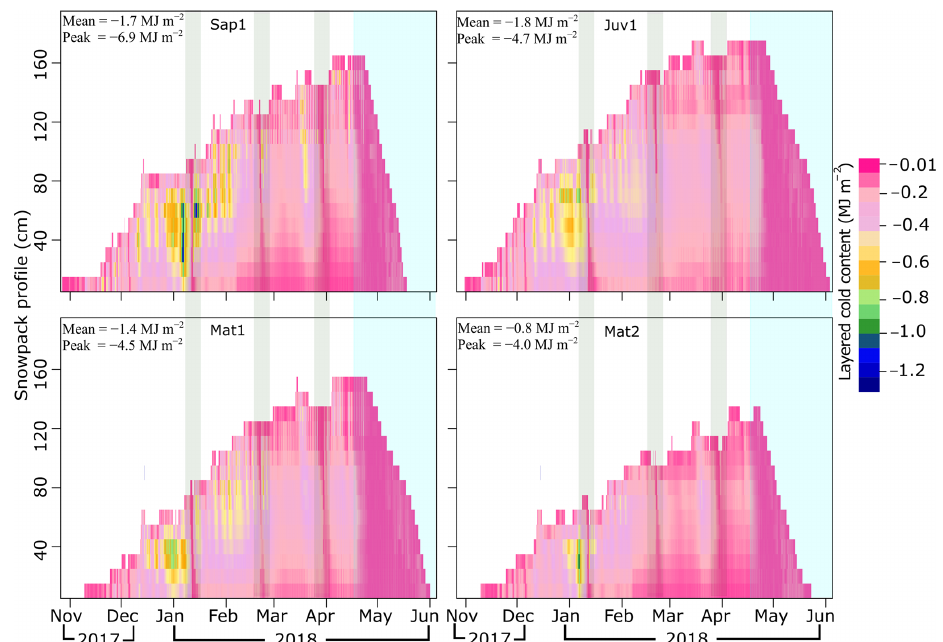
Figure 9. Seasonal variability of 10cm CC simulations stored at 30min time intervals. The colour bar indicates CC values in MJm − 2 . Light green shading represents rain-on-snow events, and light blue shading represents melt.